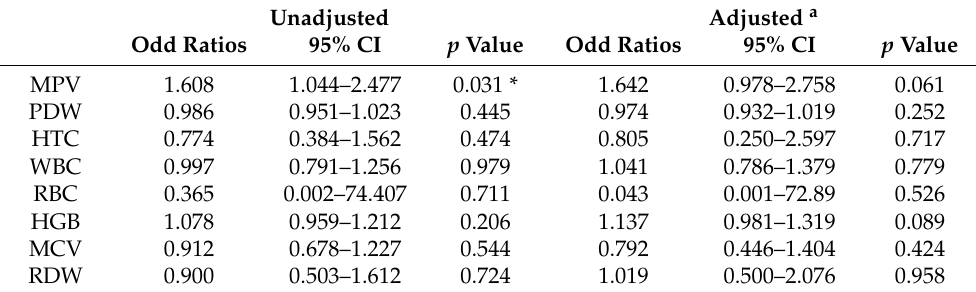
Table 5. Logistic regression analysis for GAD-7 determined